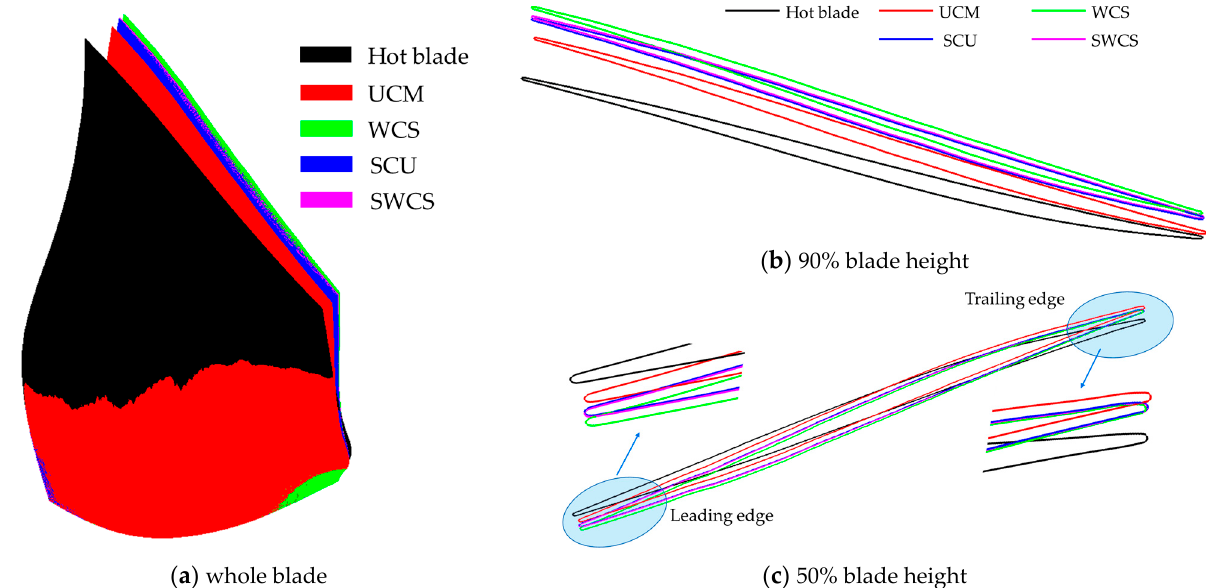
Figure 15. Comparison of the hot and cold